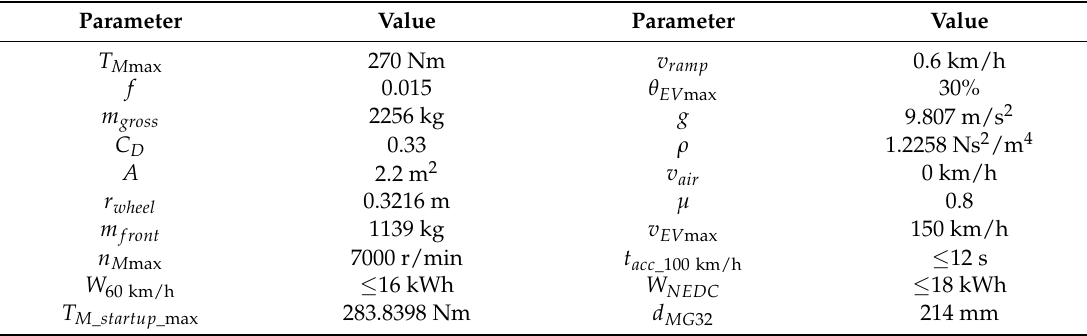
Table 1. Parameters and requirements of the electric vehicle (EV).